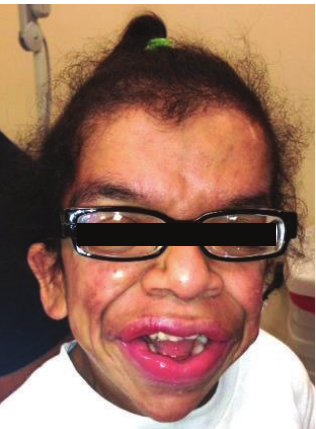
Figure 1: Facial manifestation in Costello